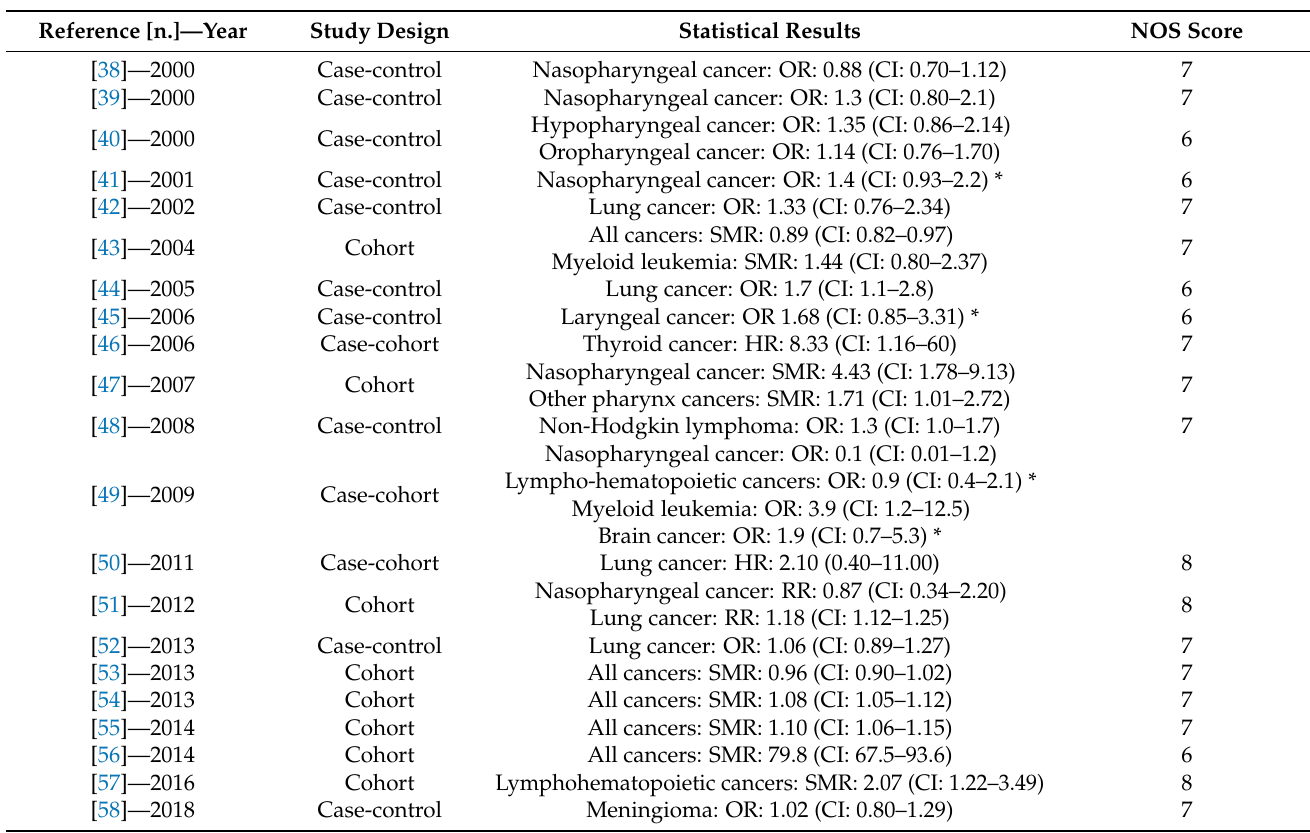
Table 2. Scoring results of the included studies in relation to study design, year of publication, and statistical results